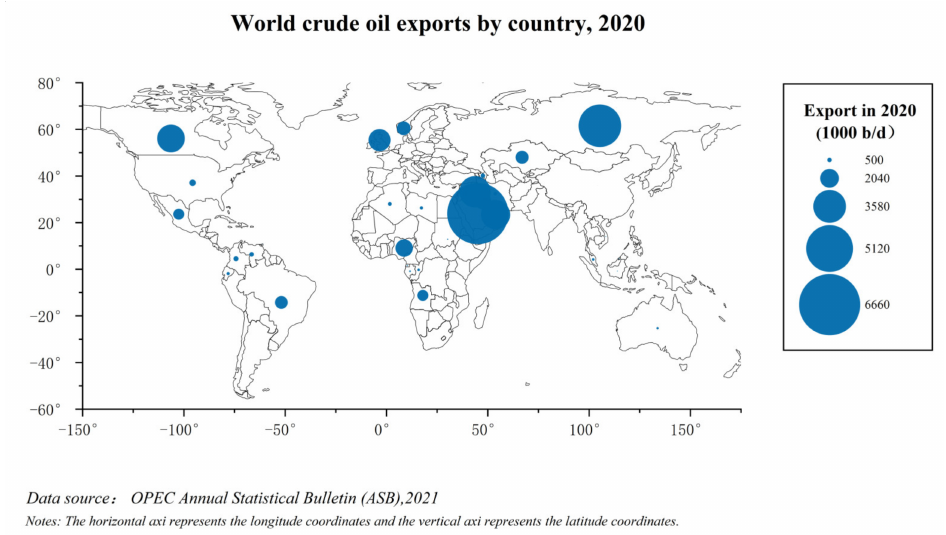
Figure 1. The first 20 largest oil exporting countries in